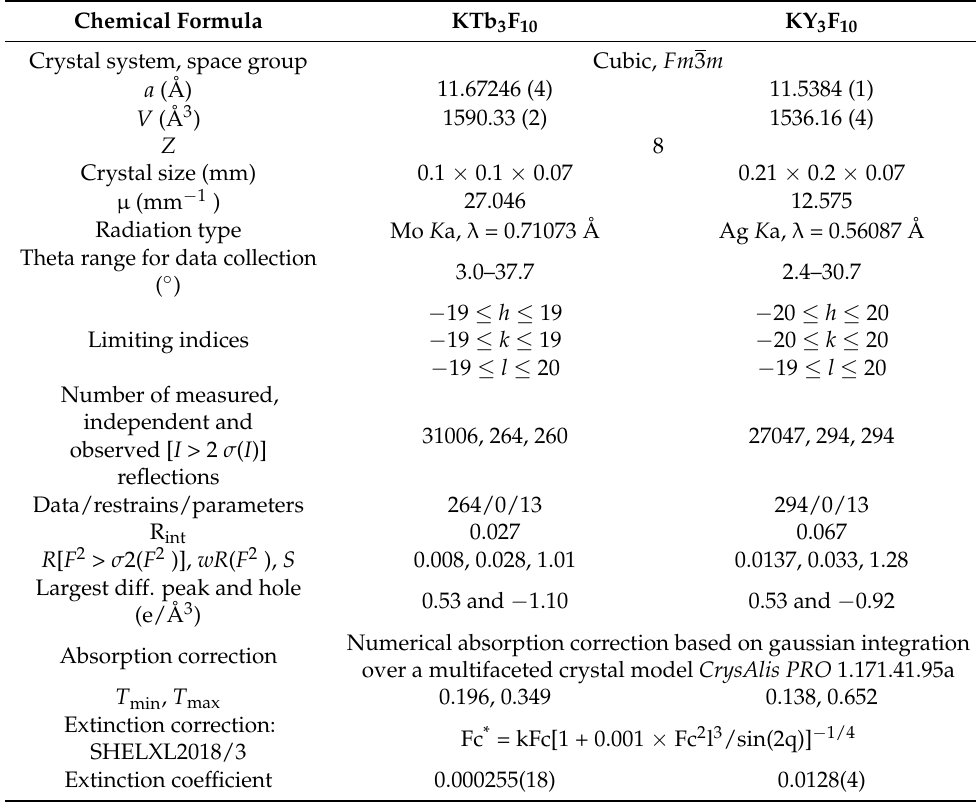
Table 1. Crystal data for KTb 3 F 10 and KY 3 F 10